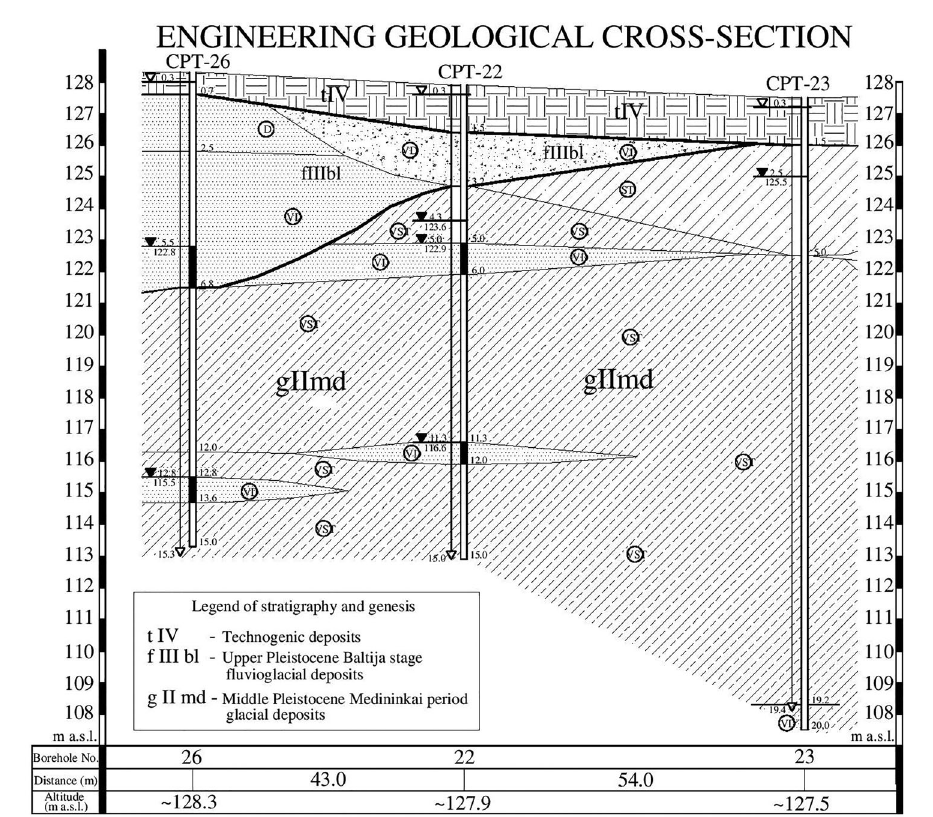
Fig. 3. One of engineering geological cross sections from the study site (Geotestus 2017). D, dense; VD, very dense; ST, stiff; VST, very stiff. For the description of deposits see Fig.